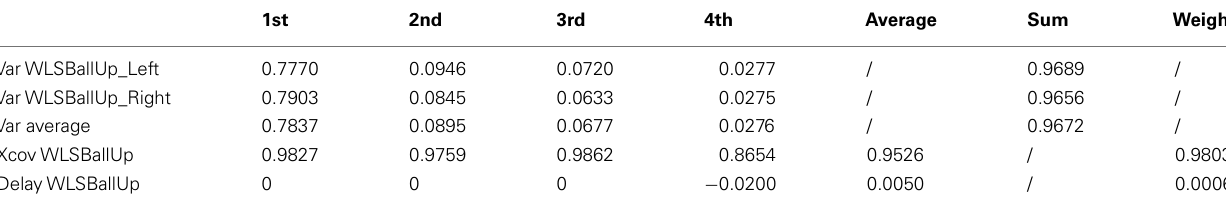
TableA8 | Reaching a target with the left and the right hand while walking (2 subjects).